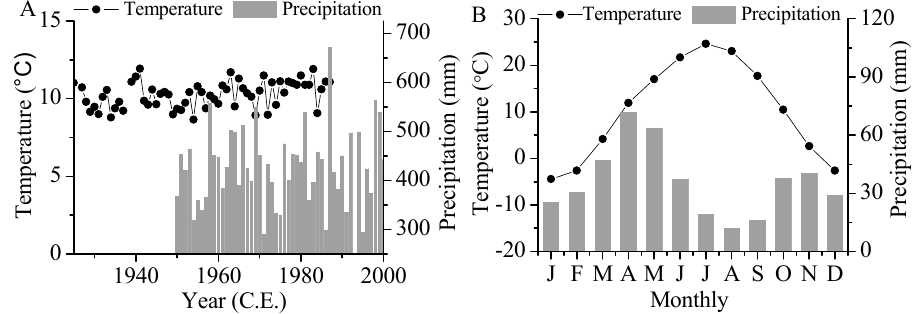
Figure 3. Annual ( A ) and monthly ( B ) changes in mean temperature (1925–1988) and total precipitation (1950–2000) at the Frunze meteorological station.